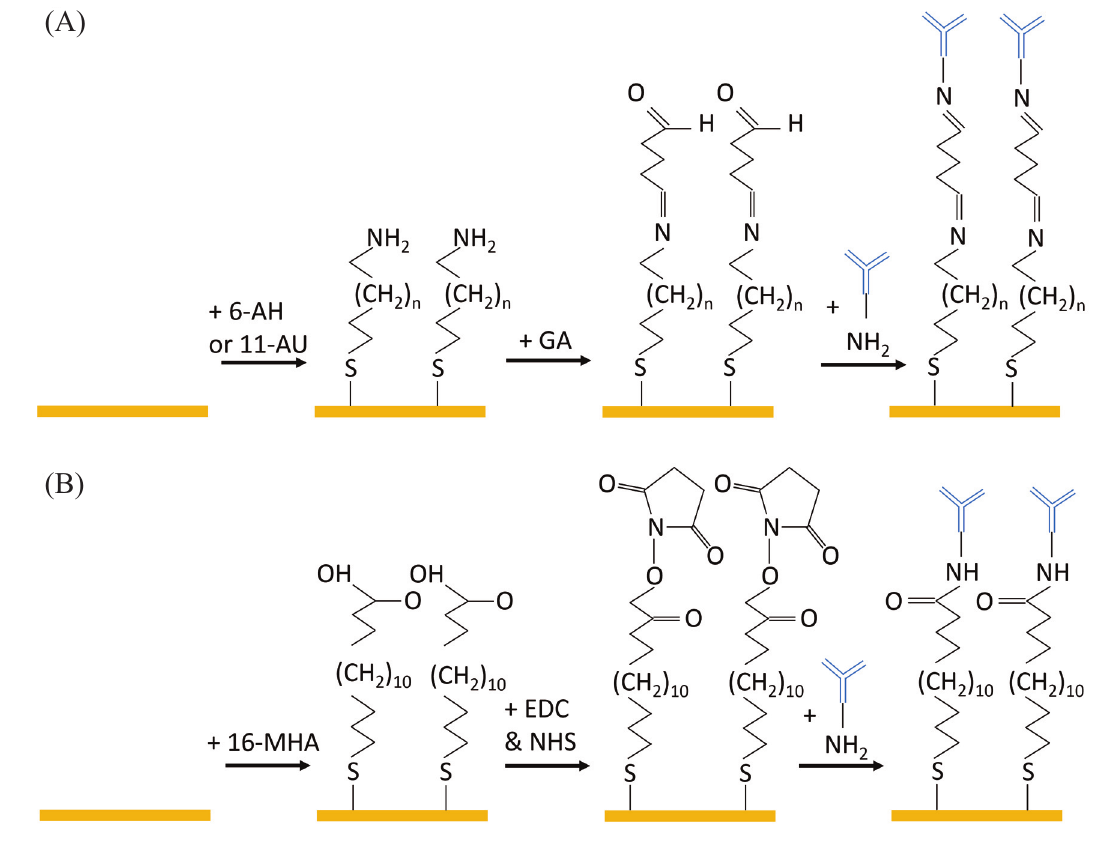
Fig. 1. Biofunctionalization of gold surfaces with rabbit IgG antibodies using different hydrophobic spacers: 6­amino­1­hexanethiol hydrochloride (6­AH) or 11­amino­1­undecanethiol hydrochloride (11­AU) (A) and 16­mercaptohexadecanoic acid (16­MHA)